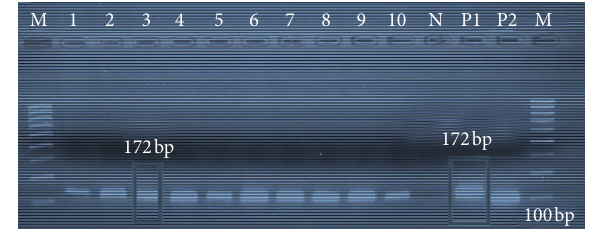
Figure 5: Classical PCR gel picture from skin nodule and nasal swabs of LSDV infected cattle. Lane M: DNA ladder (100bp, Fermentas); lanes 1–10 represent positive samples from Sawena district of Bale; N: negative control without template; P1: positive control for LSD; P2: positive control for SPP.